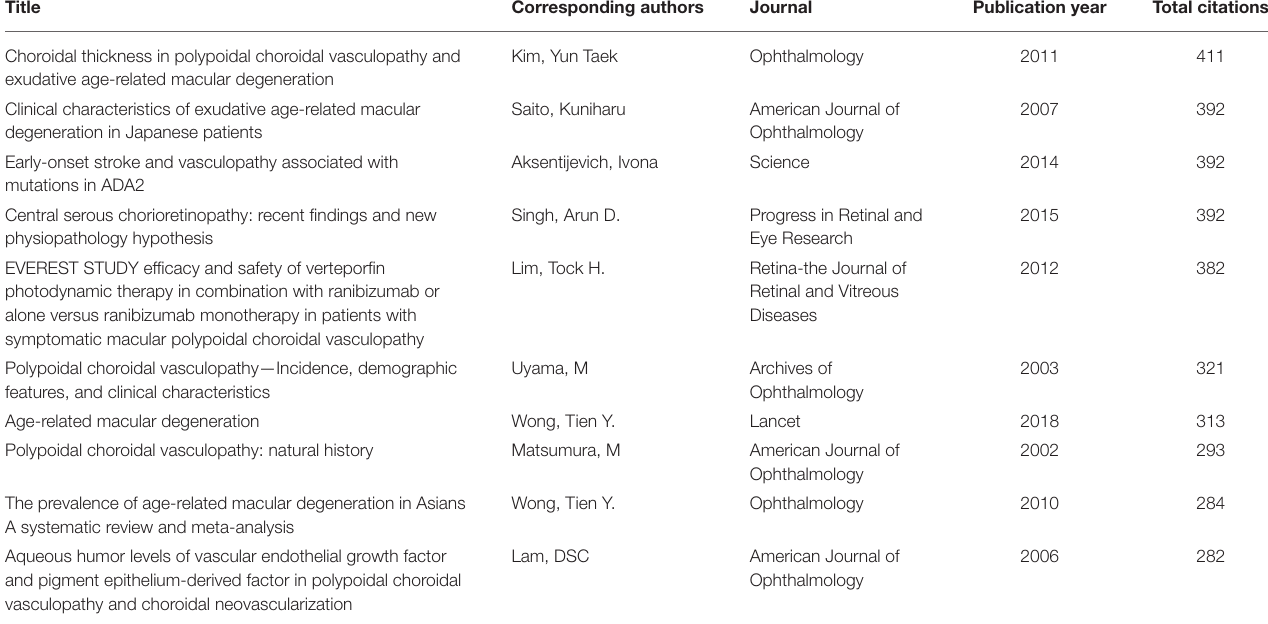
TABLE 1 | The top 10 papers with the most citations in PCV research.